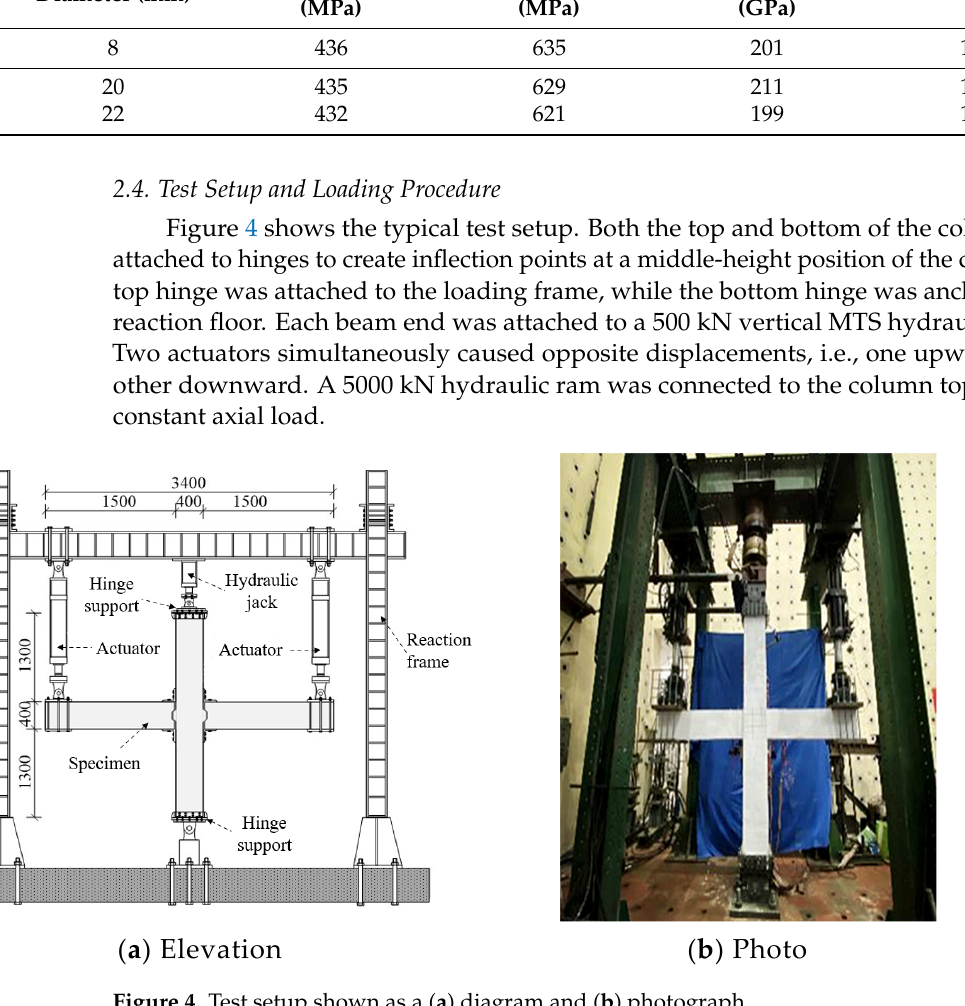
Figure 3. The tensile stress–strain curves of materials. ( a ) SMA-ECC; ( b ) ECC.